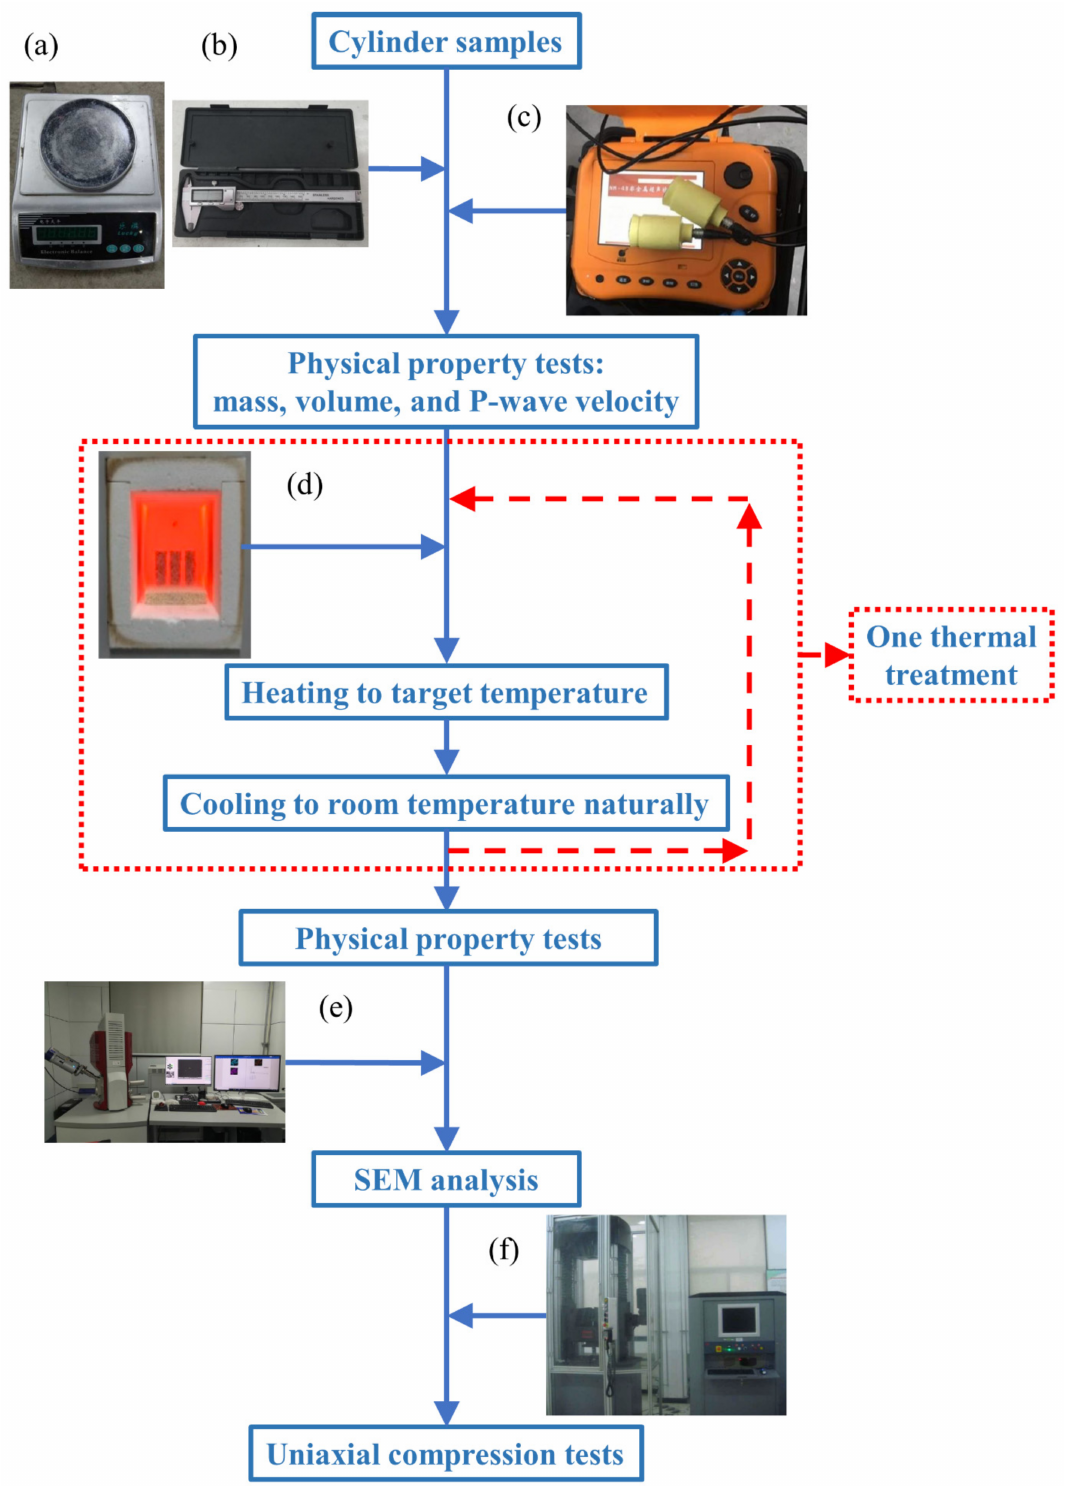
Figure 2. Experimental procedures and equipment: ( a ) mass measurement, ( b ) dimension